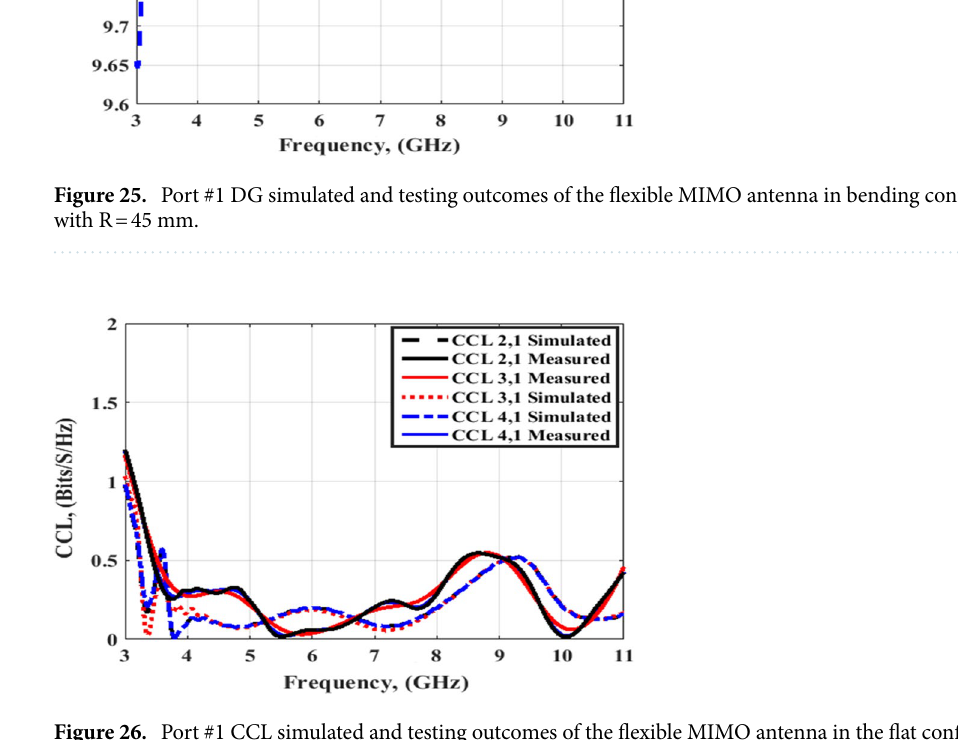
Figure 26. Port #1 CCL simulated and testing outcomes of the flexible MIMO antenna in the flat